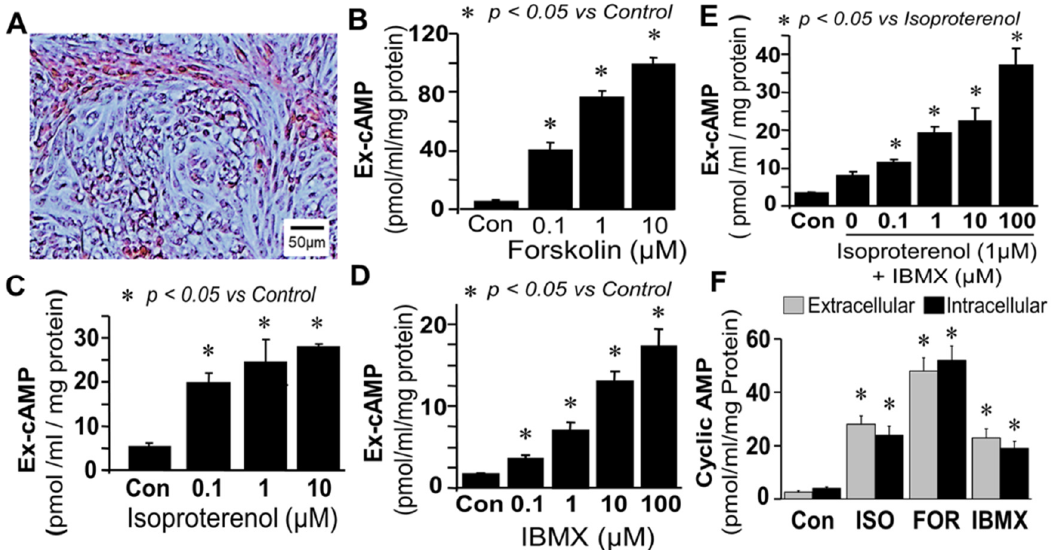
Figure 1. Panel ( A ) depicts a representative photomicrograph (40x magnification) of FT cells (mixed cultures of epithelial cells and fibroblasts 1:1 ratio). Bar graphs show the concentration-dependent stimulatory effects of treatments on extracellular (Ex) cAMP levels in confluent monolayer of FT cells after 15 min stimulation with: forskolin (0.1, 1, 10 µ M), Panel ( B ); isoproterenol (0.1, 1, 10 μ M), Panel ( C ); IBMX (0.1, 1, 10, 100 μ M), panel ( D ); and IBMX (0.1–100 μ M) plus isoproterenol (1 μ M), Panel ( E ). Bar graph in Panel ( F ) shows changes in intracellular and extracellular cAMP levels in response to 1 μ M forskolin (FOR), 10 μ M isoproterenol (ISO) or 1 μ M IBMX. Data (mean and SEM) in bar graphs represent the mean of three different experiments ( n = 3), with each experiment conducted in triplicate. Values were normalized to total protein concentration and the cAMP levels are expressed as pmol/mL/mg protein. * p < 0.05 vs. control.